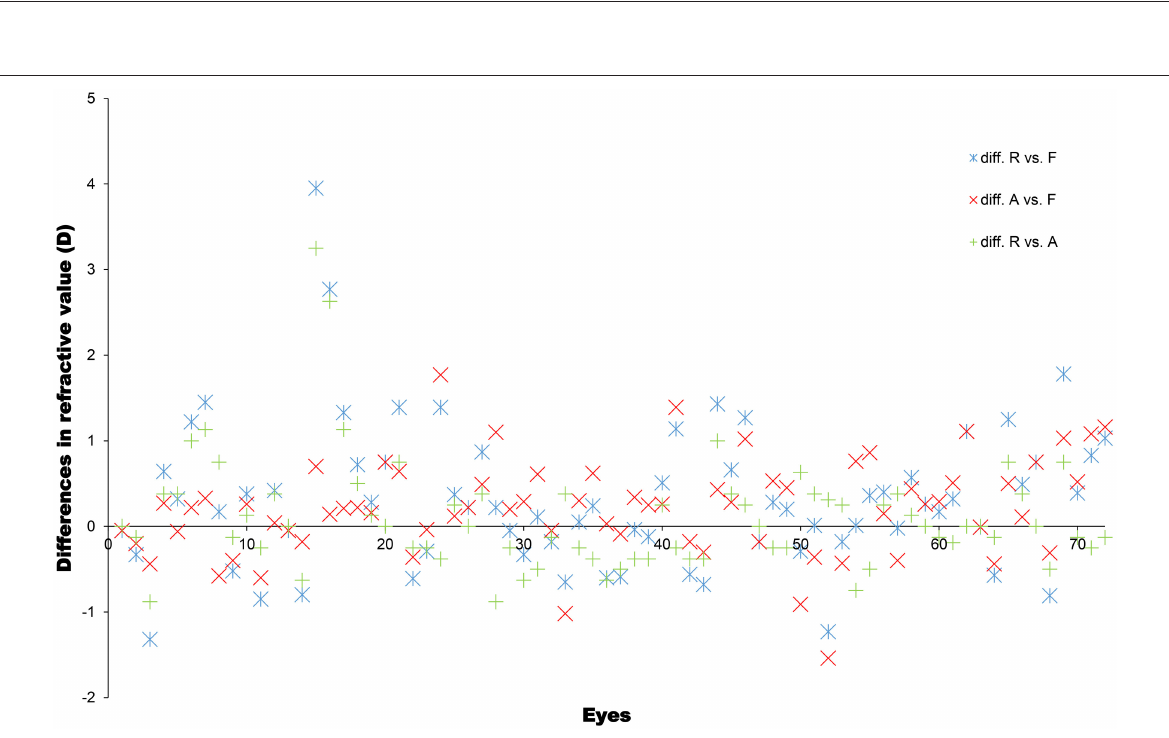
Frontiers in Medicine | www.frontiersin.org